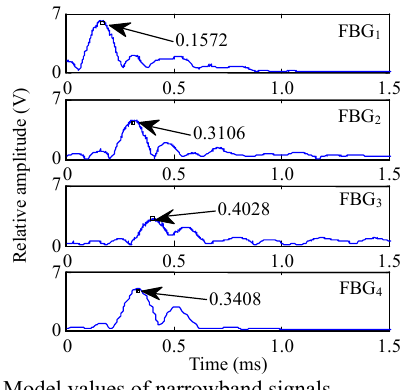
Fig. 6 Model values of narrowband signals.